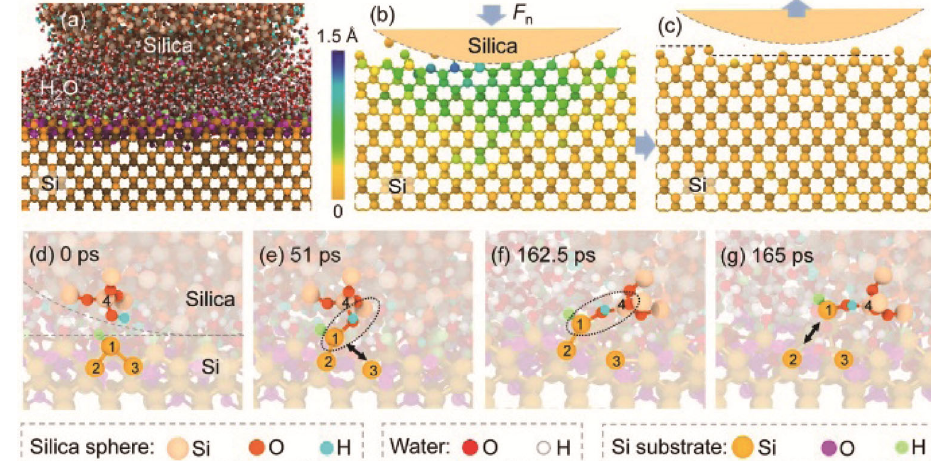
Fig. 11 (a) Tribochemical wear of Si surface against silica nano-sphere in MD simulation; (b) sliding model in MD simulation; (c) deformation of Si substrate under load condition ( Z direction displacement of Si atom under contact pressure is denoted by different colors). (d–g) Removal of Si atoms and release of substrate deformation after unloading: (d) tribochemical reaction process: initial contact interface reacting with water to form Si–H and Si–OH groups; (e) formation of interfacial bond bridge between Si substrate and silica surfaces, and breaking of one Si–Si bond of Si substrate; (f) tensile stress transferred across interfacial bonding bridges; and (g) fracture of another substrate bond and removal of Si atom. Reproduced with permission from Ref. [116], © Nature